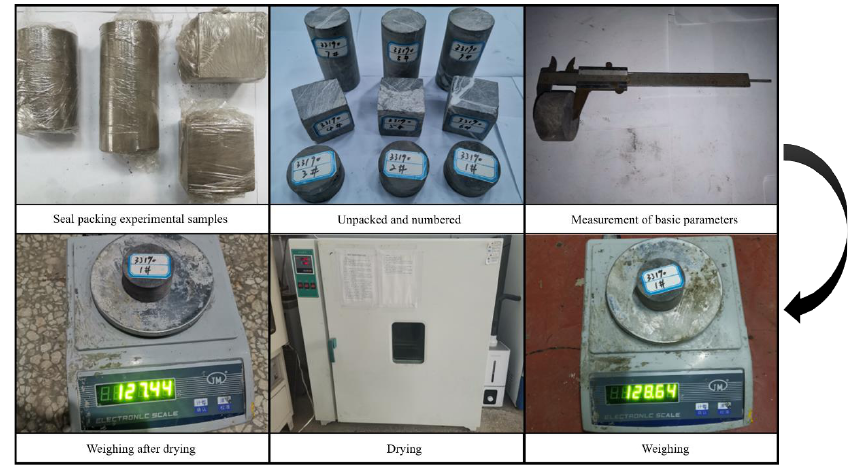
Figure 4. Results of temperature field tests on the surrounding rock.